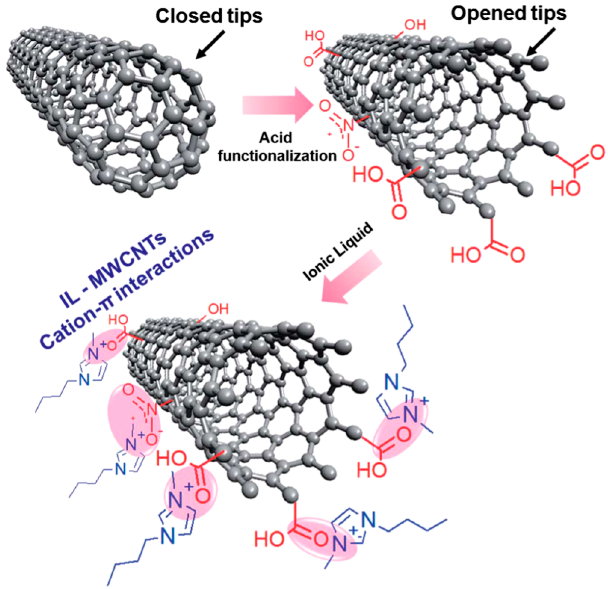
Figure 5. Illustration of the ”cation– π ” interaction between IL and MWCNTs after functionalisation. Note: in this illustration, for simplicity, a single-walled carbon nanotube (SWCNT) was used in place of the MWCNT. (Reproduced with permission of Royal Society of Chemistry from [104]).